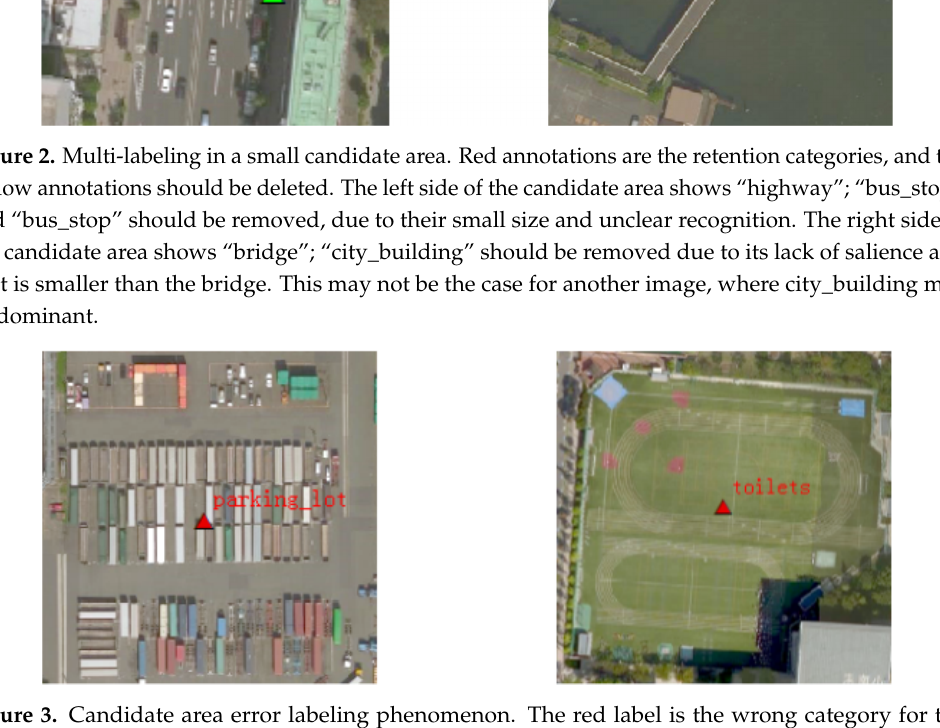
Figure 3. Candidate area error labeling phenomenon. The red label is the wrong category for the images. The left area should be labeled as “container”, not “parking_lot”. The right area should be labeled “artificial_grassland”, not